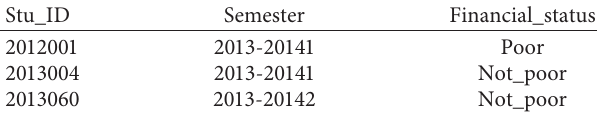
Table 4: Data format of poor student list.